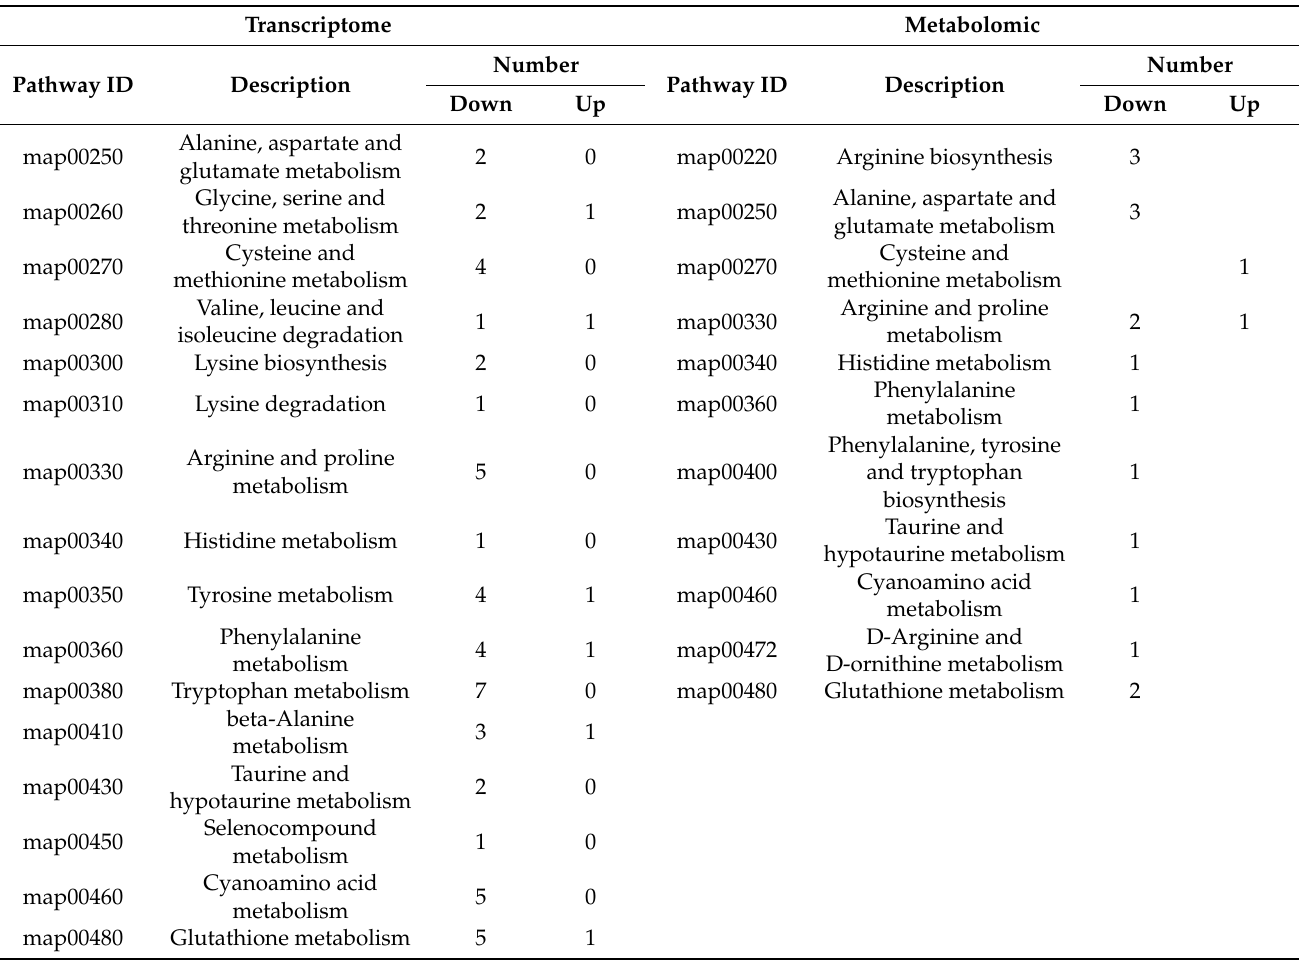
Table 4. Amino acid metabolic